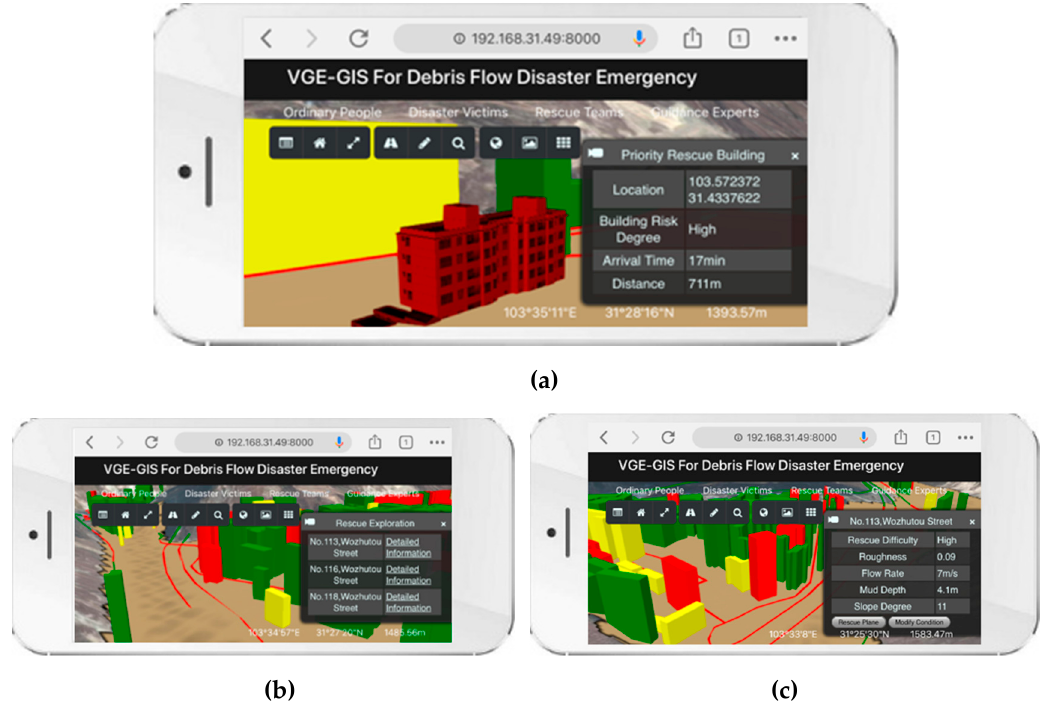
Figure 9. Virtual debris flow disaster environment for rescue teams on mobile terminals: ( a ) Users can observe relevant information for disaster victims; ( b ) step 1 of the interactive and explorative rescue process; ( b ) step 2 of the interactive and explorative rescue process.